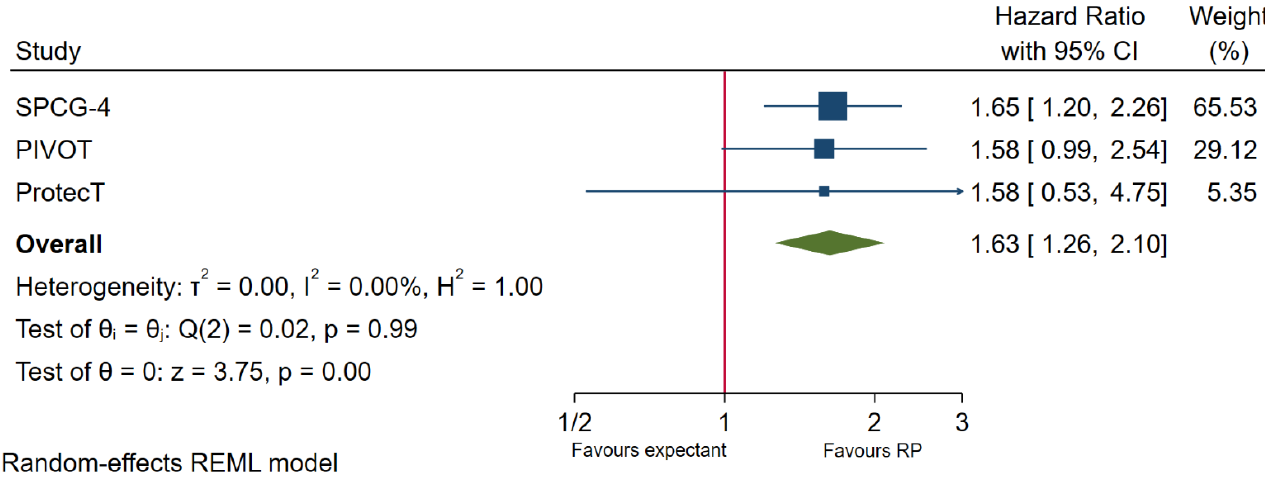
Figure 2. Overall survival in expectant management versus immediate RP.